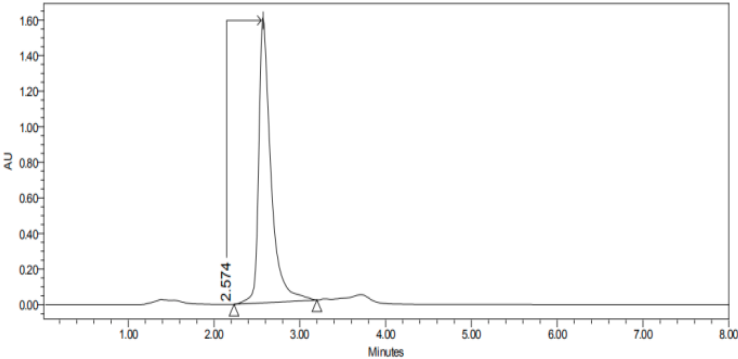
Figure 3. Chromatogram of CP-NPs in cornea at 6 h.